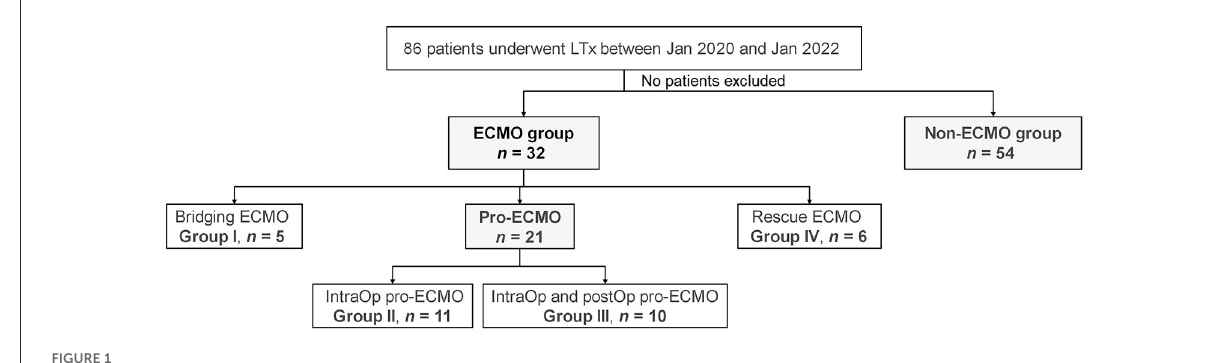
FIGURE1 Flow chart of the study